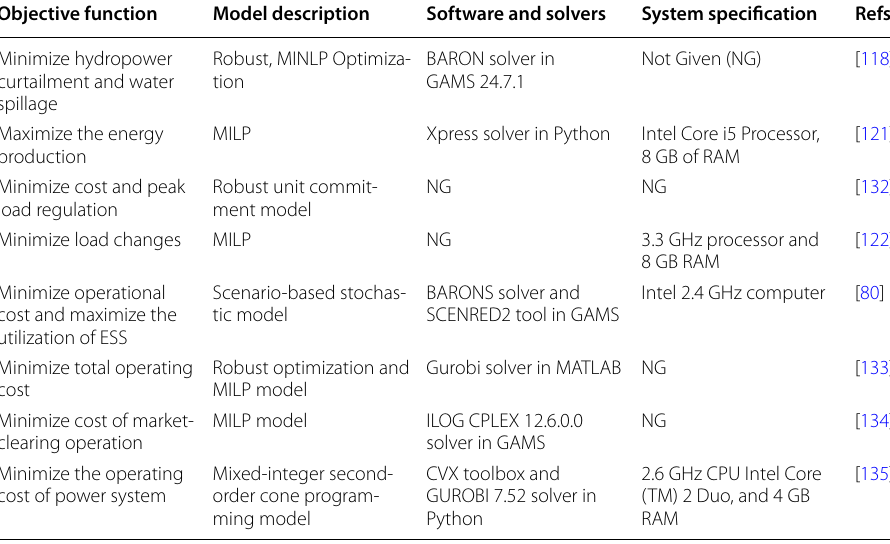
Table 8 Review of operational optimization models in power